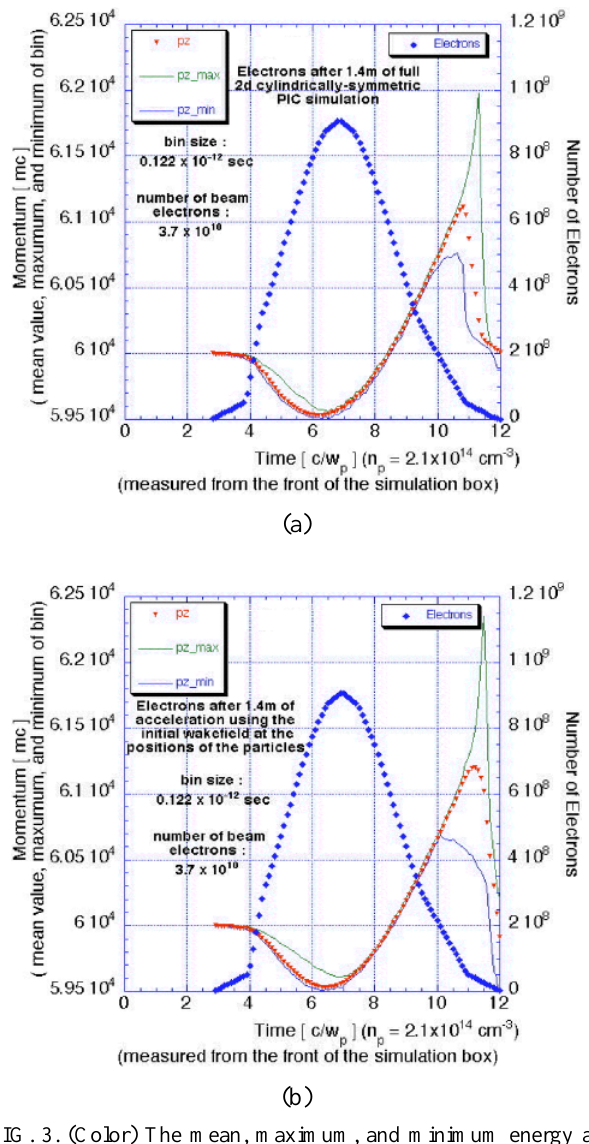
FIG. 3. (Color) The mean, maximum, and minimum energy as well as the number of electrons for each 0.12 psec bin after 1.4 m of propagation using (a) the full PIC simulation and (b) the initial fields at the initial positions of the particles to propagate the